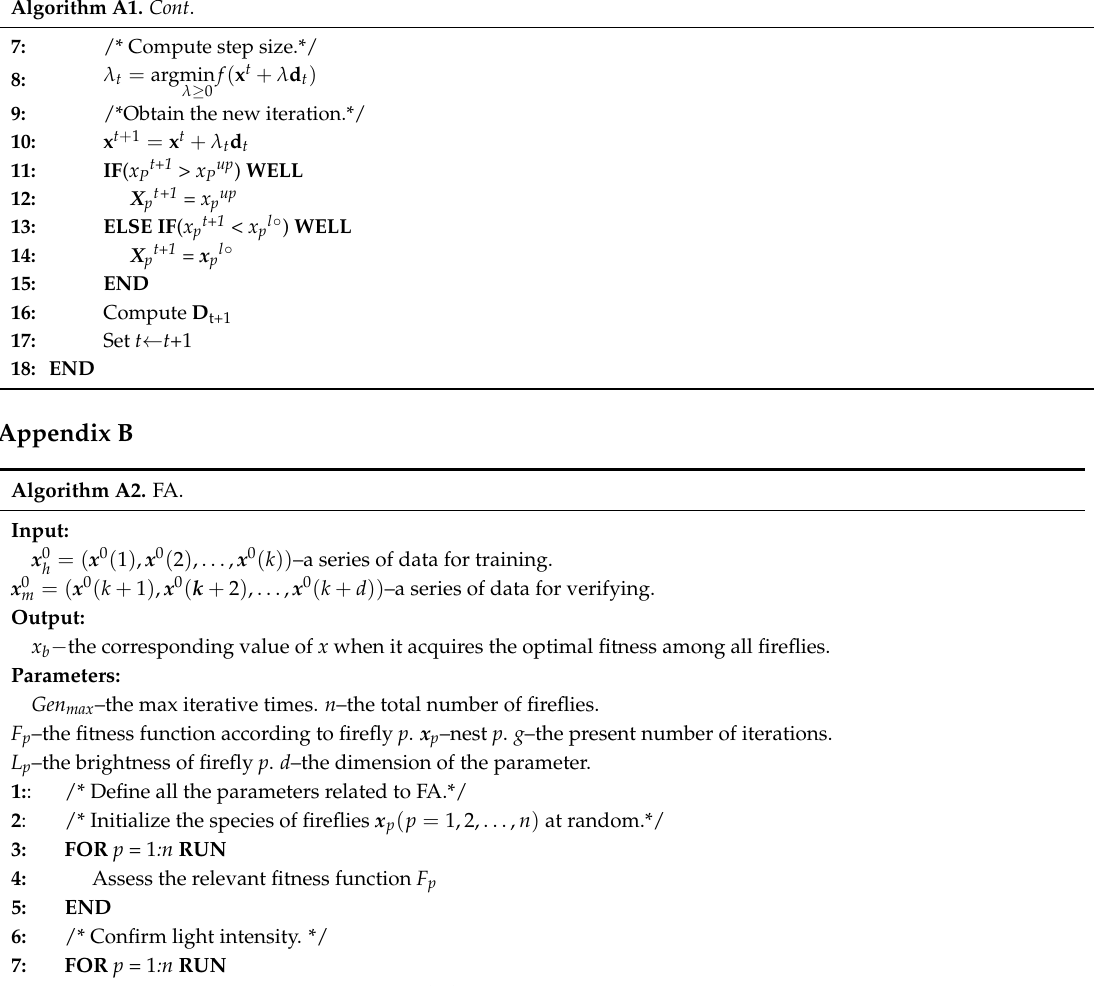
Assess the relevant fitness function F